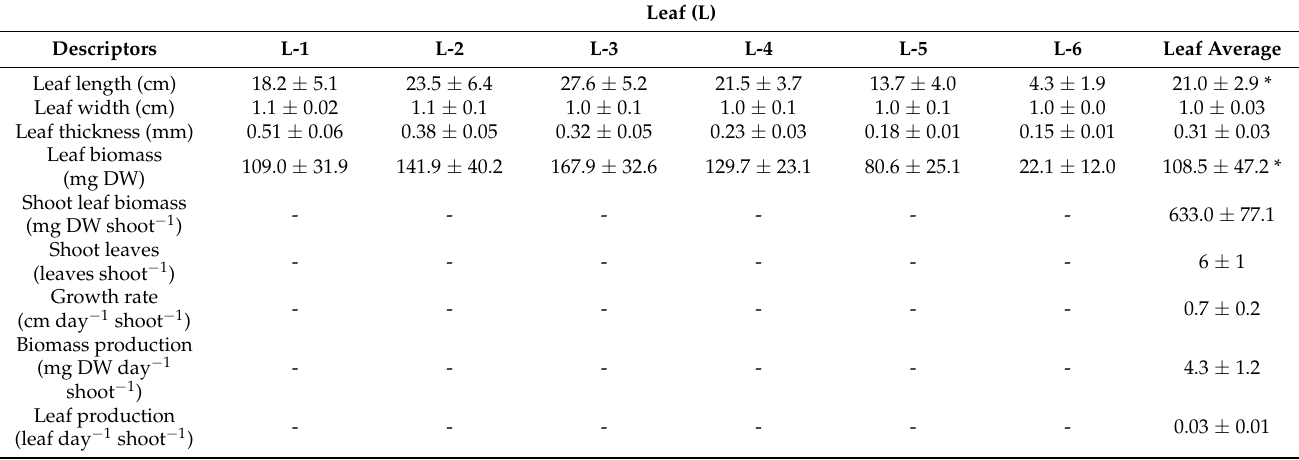
Table 1. Morphometric descriptors: leaf (L) length (cm), leaf width (cm), leaf thickness (mm), leaf biomass (mg DW), shoot leaf biomass (mg DW shoot − 1 ), number of leaves (leaves shoot − 1 ) and production descriptors: leaf growth rate (cm day − 1 shoot − 1 ), leaf biomass production